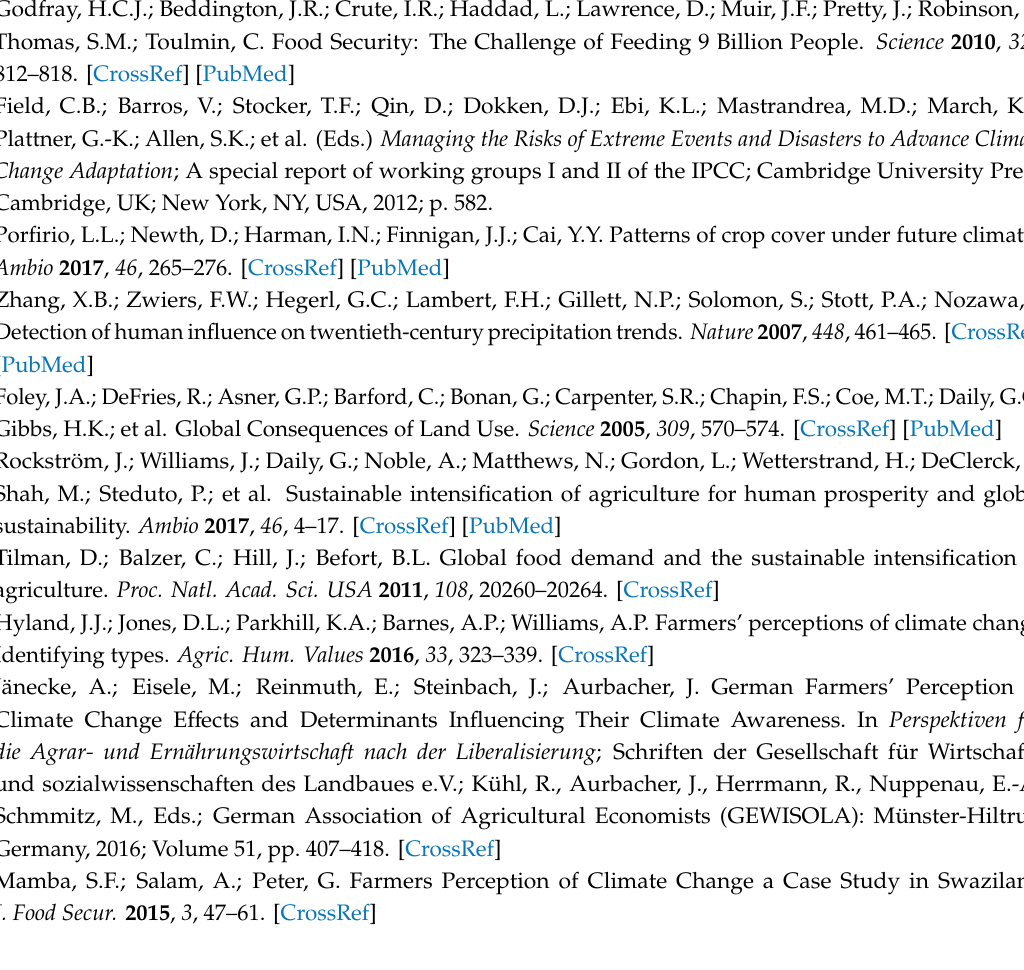
Figure S1: Farmers’ preferences for data collection for getting subsidies, Table S1: Sociodemographic data and agricultural operating information of survey respondents. SURVEYVARIABLES.csv and SURVEYDATA.csv: data and metadata of farmer